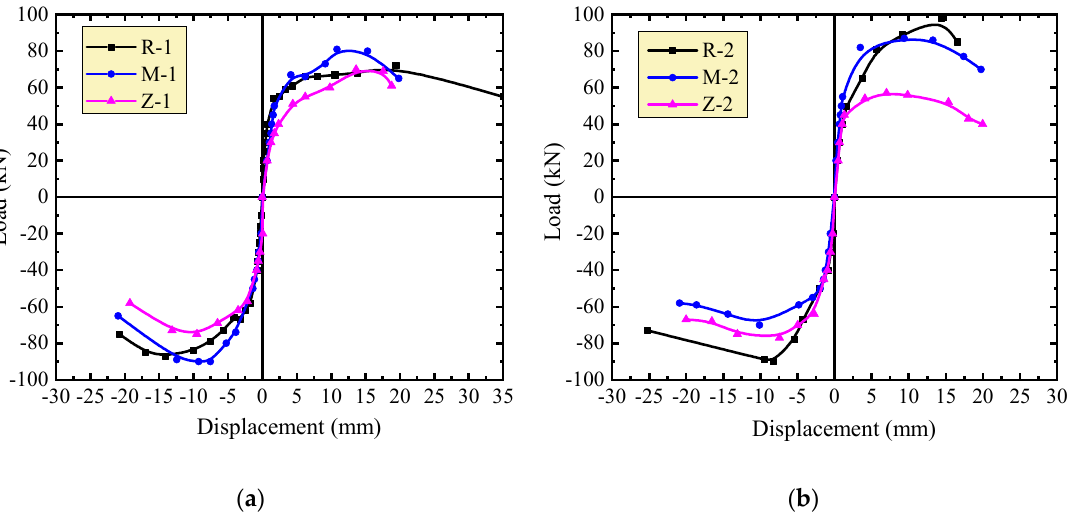
Figure 7. Comparison of envelope curves of different walls under the same vertical load: (a) σ 0 = 0.3 MPa; (b) σ 0 = 0.5 MPa. Table 2. Tested load and displacement at feature points of hysteretic curves (push and pull).